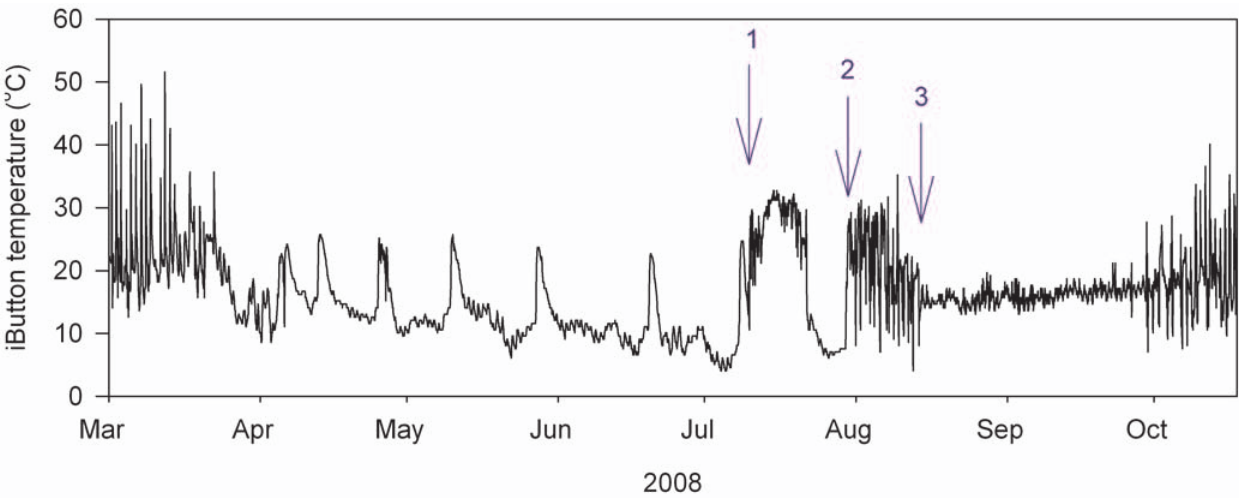
Figure 2. External temperature logger record from female echidna 0118. She entered hibernation in March, and her final arousal was on July 27 (arrow 2), when temperature variability increased. The subsequent reduction in variability (arrow 3) is associated with entry into the nursery burrow and egg-laying. Periodic arousals can be seen between April and July. In mid-July she shows an extended arousal (July 10–21), and we presume fertilization occurred at the time indicated by arrow 1.